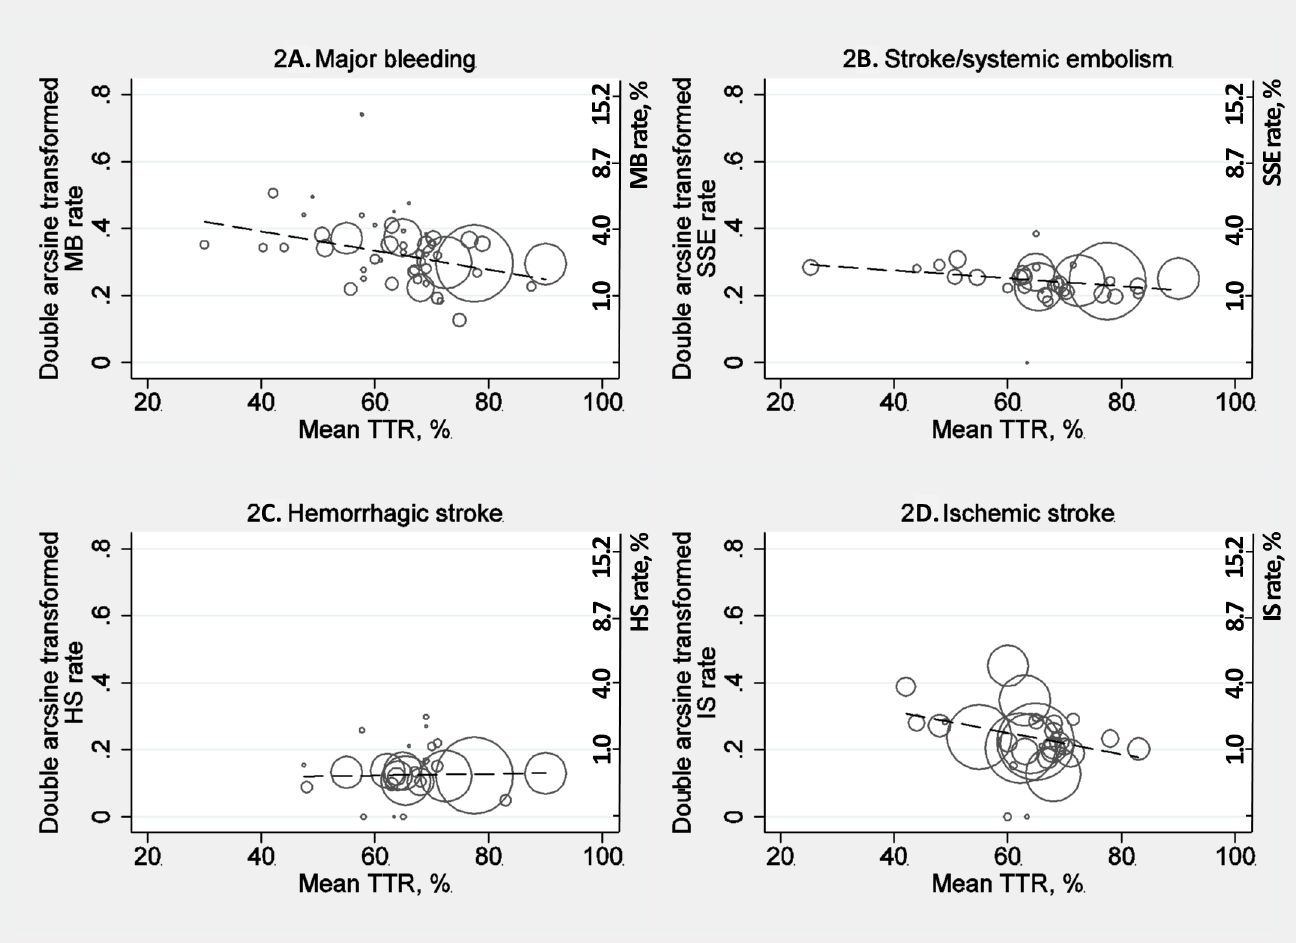
Fig 2. Bubble plots including fitted regression lines. Fitted meta-regression models with mean TTR as predictor of outcomes, respectively hemorrhagic stroke, ischemicstroke, major bleeding,and stroke/systemic embolism.Circles are sized inverselyproportionally to the estimated within- study varianceof effect reportedin studies. The dashedline indicatesthe fitted regression line. S2 Fig suppliesillustrationof study weights appliedin the random-effects meta-regressions. HS: Hemorrhagic stroke, IS: Ischemic stroke, MB: Major bleeding,SSE: Stroke/systemic embolism, TTR: Time in therapeutic